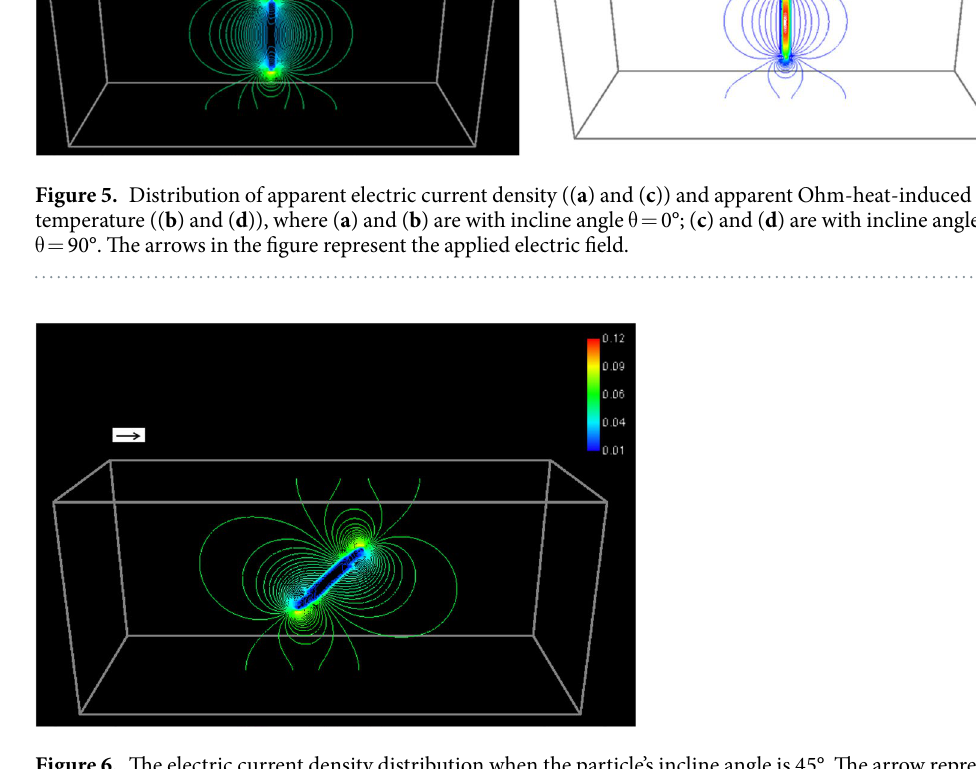
Figure 6. The electric current density distribution when the particle’s incline angle is 45°. The arrow represents the direction of applied electric